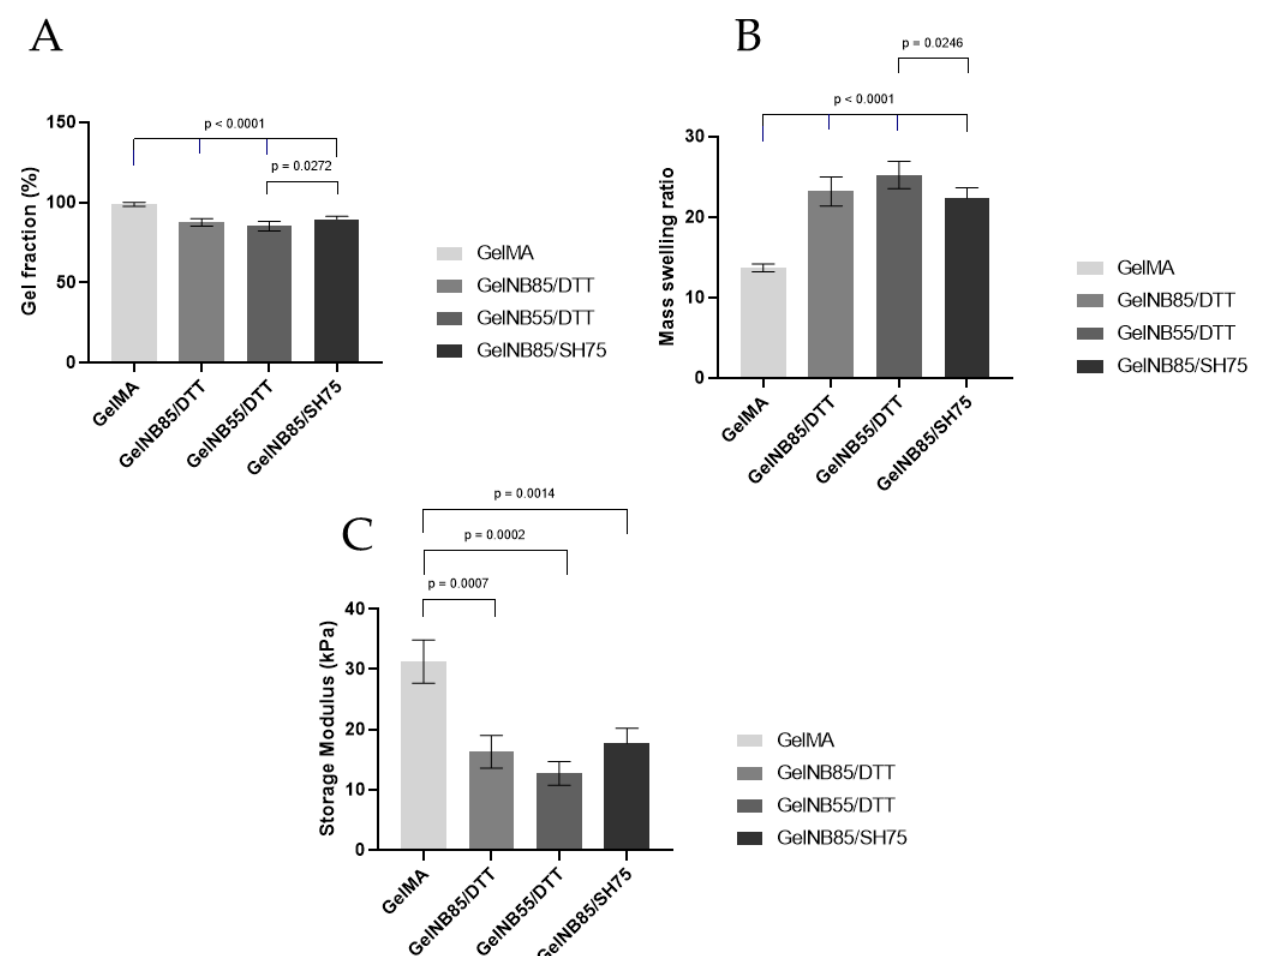
Figure 4. Physicochemical properties of the obtained hydrogel films: ( A ) gel fraction, ( B ) mass swelling ratio, and ( C ) mechanical properties of 10 w / v % films containing 2 mol% LAP photoinitiator. Significant differences are shown with adjusted p-values and error bars representing standard deviation. DTT: 1,4-dithiotreitol; gel-MA: methacrylated gelatin; gel-NB: norbornene-functionalized gelatin; gel-SH: thiolated gelatin; LAP: lithium(2,4,6-trimethylbenzoyl) phe- nylphosphinate.